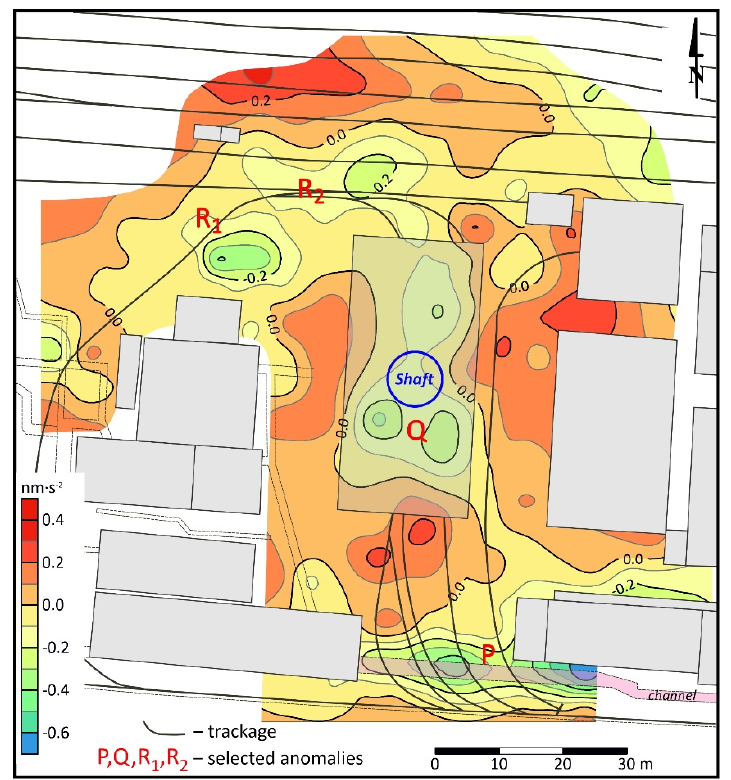
Figure 5. Distribution of the residual anomalies.